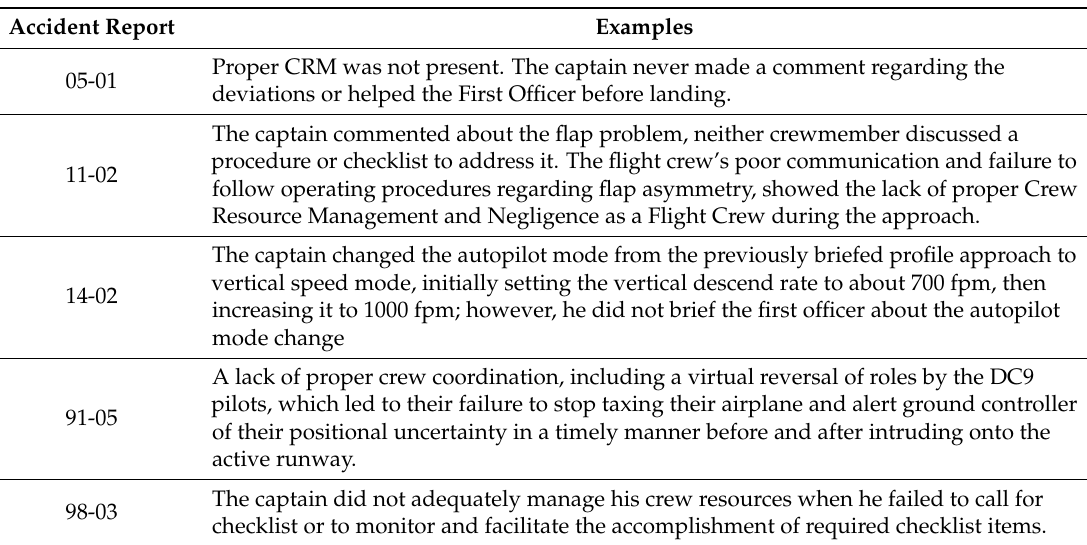
Table 11. Examples of CRM issues as contributing